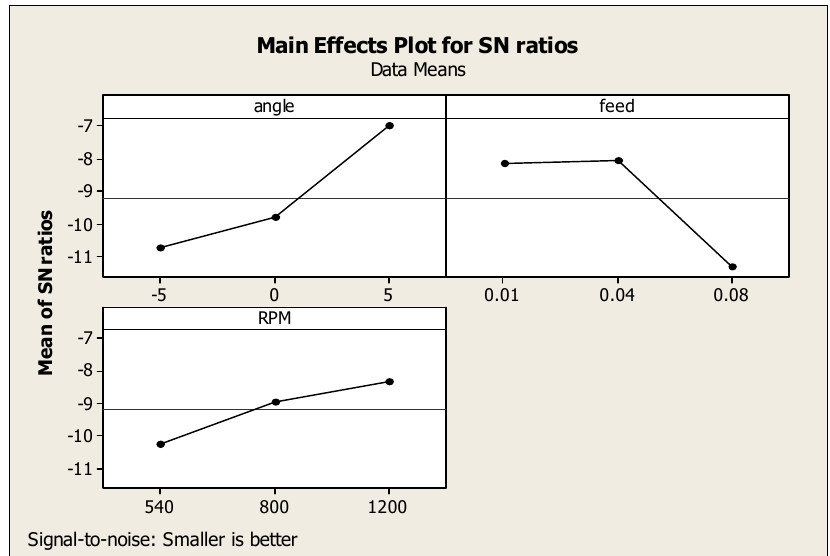
Fig. 5. Plot for signal to noise for